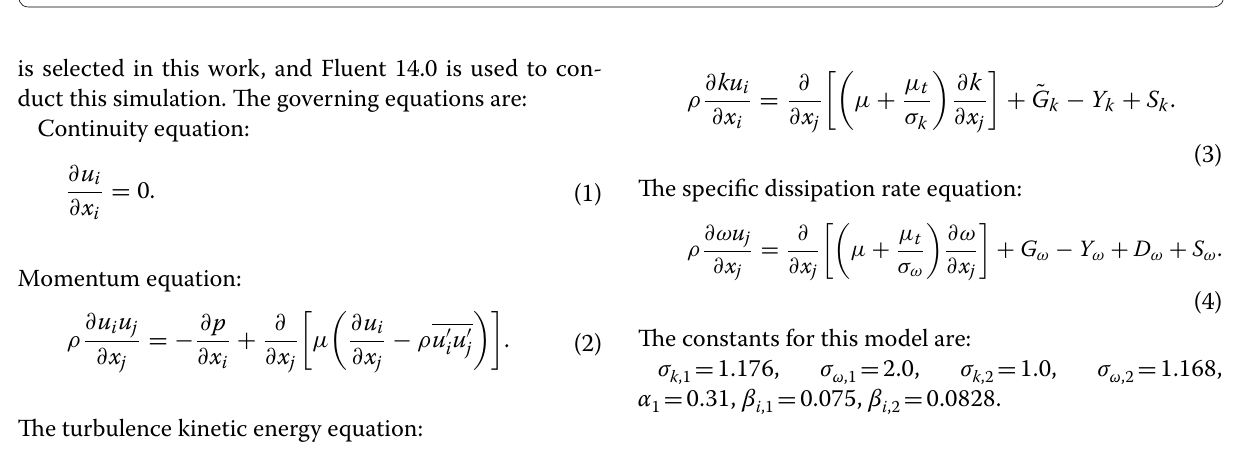
0.35 m of the tube center line where flow has =